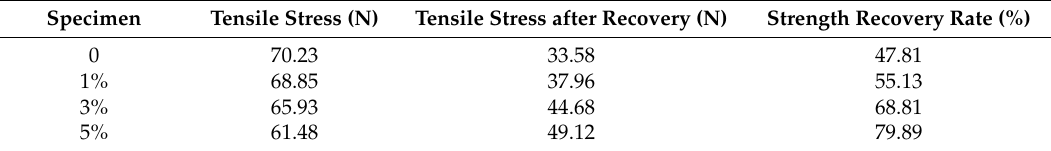
Table 4. Tensile stress of bitumen specimens with different content Ca-alginate